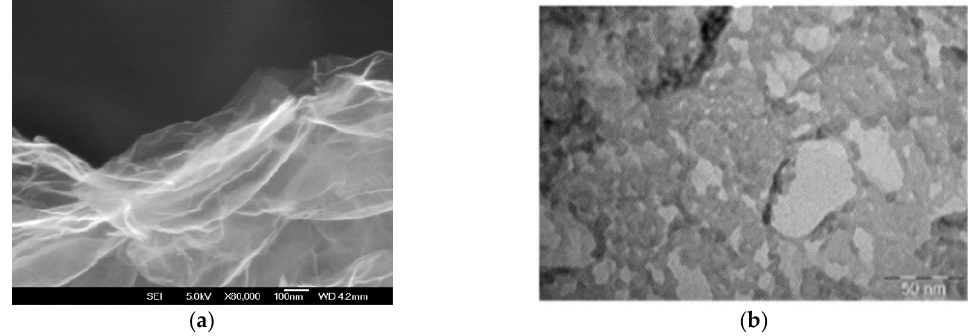
Figure 1. SEM and TEM images of ( a ) graphene and ( b ) graphene decorated with Nb 2 O 5 nanoparticles (deposition power 80